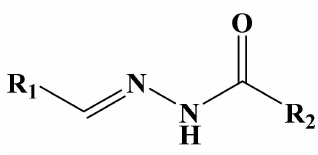
Figure 1. General Structure of Acylhydrazone. R 1 is benzene and R 2 is the pyridine